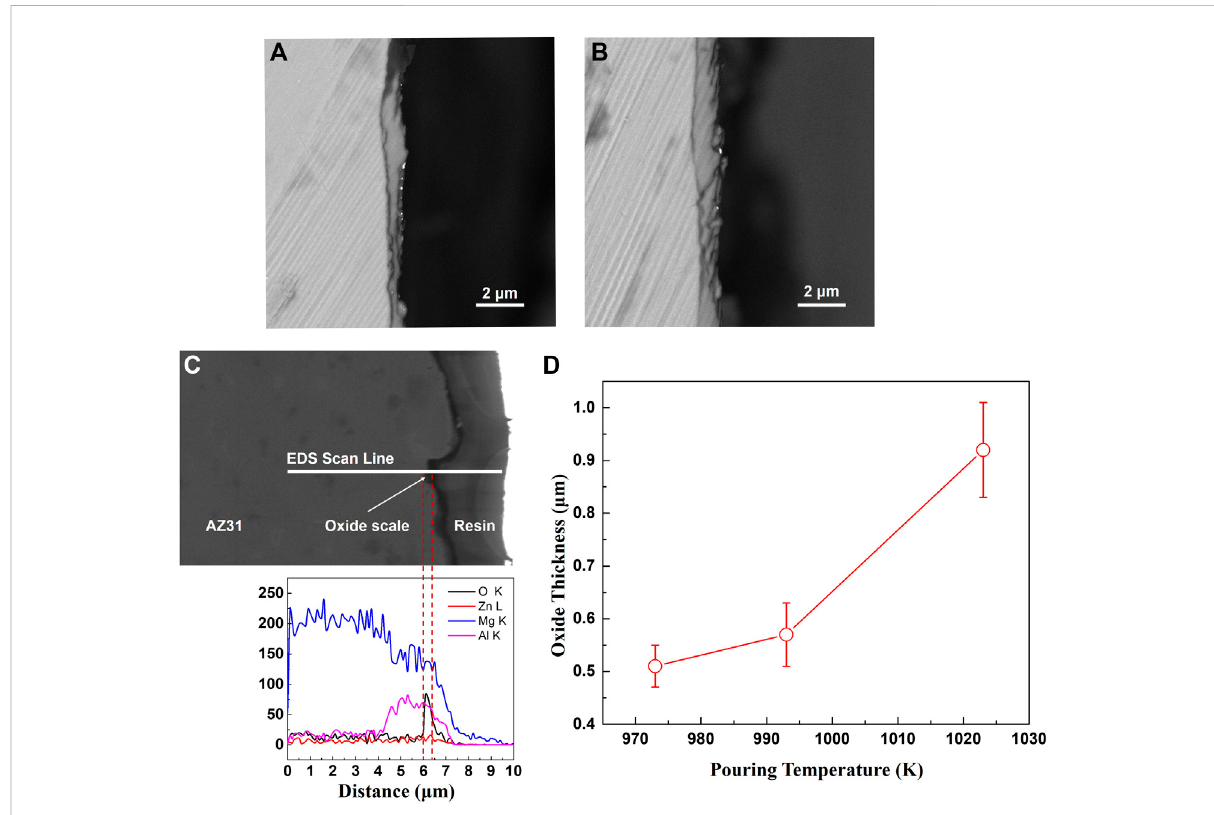
FIGURE 3 Thecross-sectionsofoxidescales formedonthecastings. (A) cooling rate0.7 K/s (B) cooling rate0.3 K/s (C) EDSanalysis ofoxidescale (D) the thickness of oxide formed at a cooling rate of 0.3 K/s.